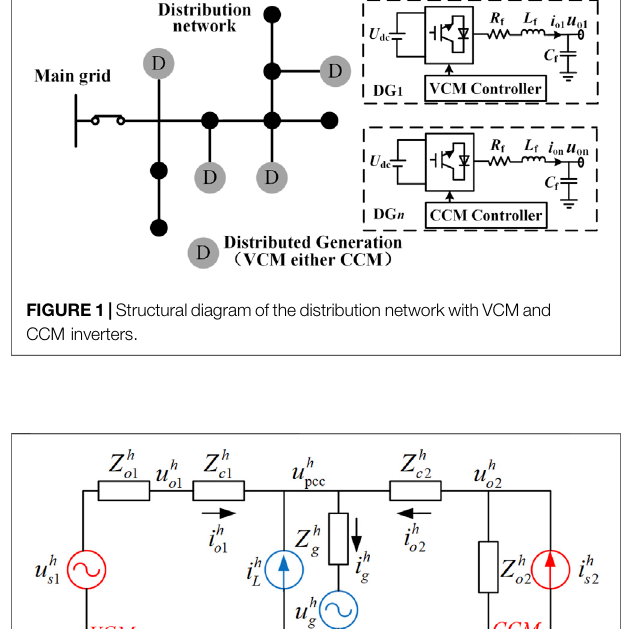
TABLE 1 | Electrical and control system parameters.